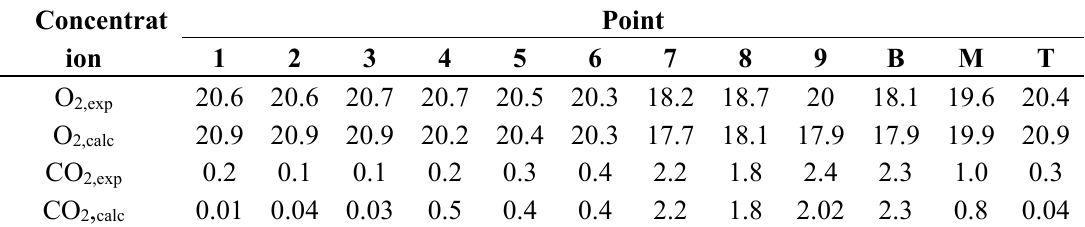
Table 1. Experimental and calculated concentration ( v / v ) at the reference